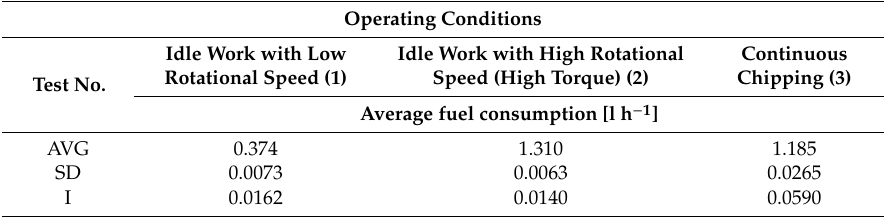
Table 3. Results of fuel consumption measurements of a cylindrical chipper powered by an internal combustion engine with an injection fuel supply system (B); AVG–arithmetic average,